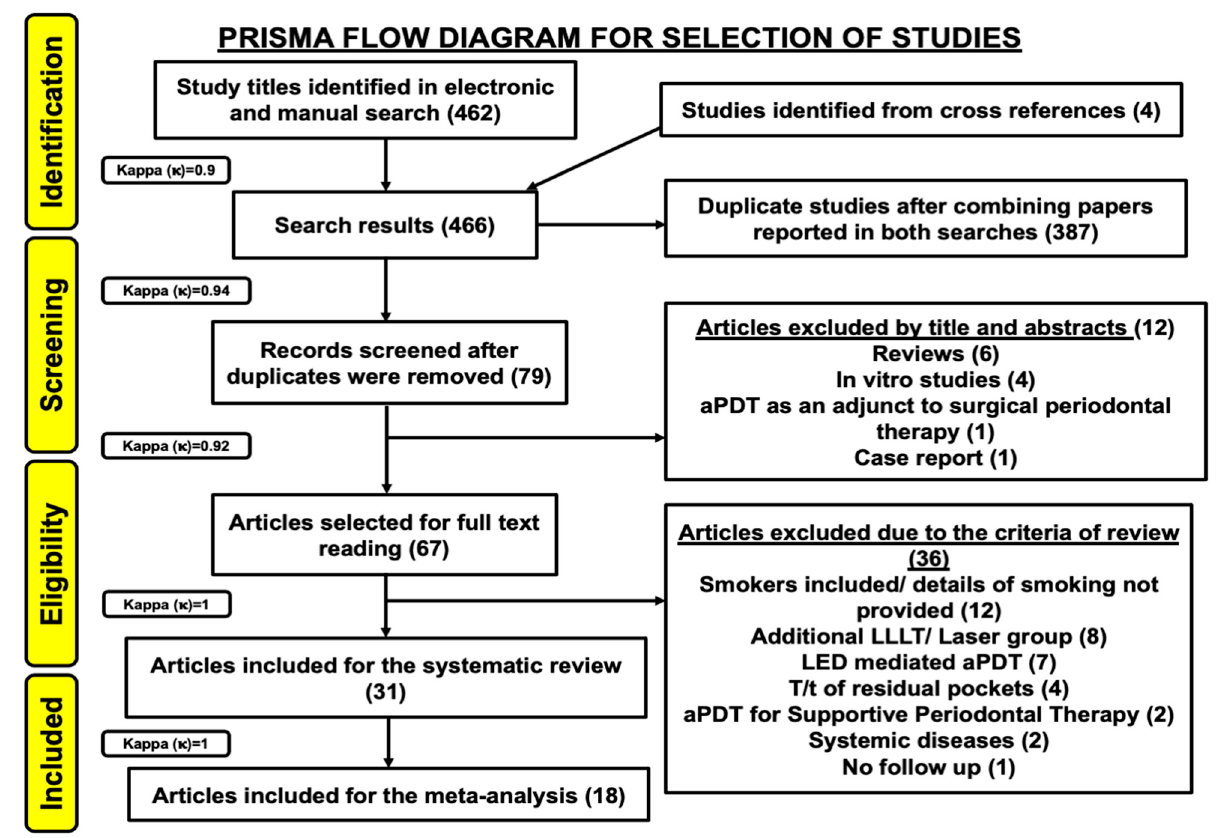
Figure 1. PRISMA flow diagram of the study selection criteria.